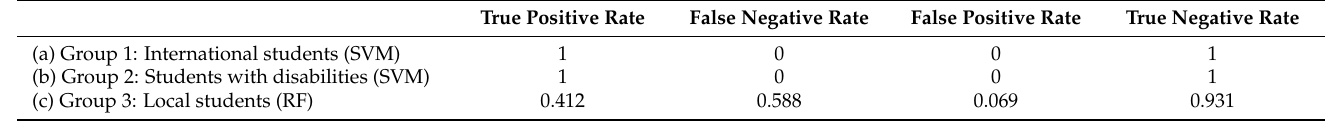
Table 4. Confusion matrix results of Case